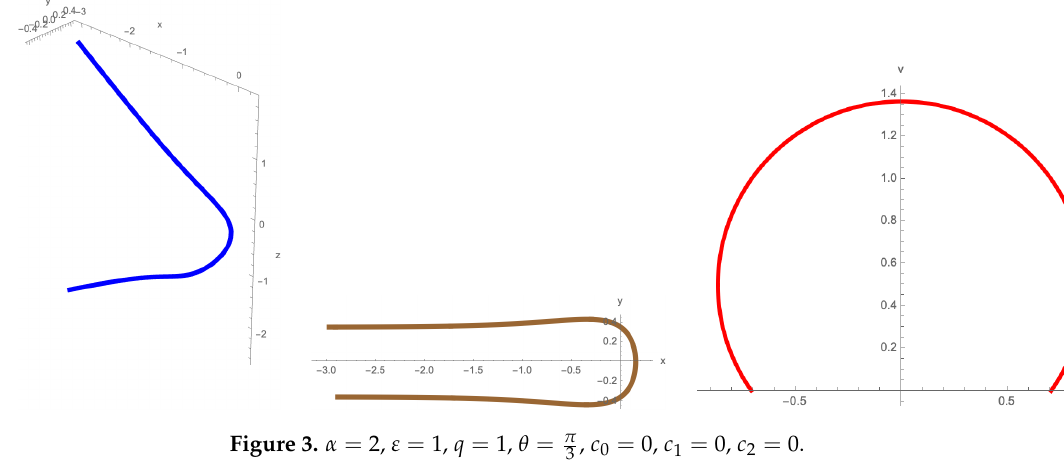
, c 0 = 0, c 1 = 0, c 2 = 0. 3